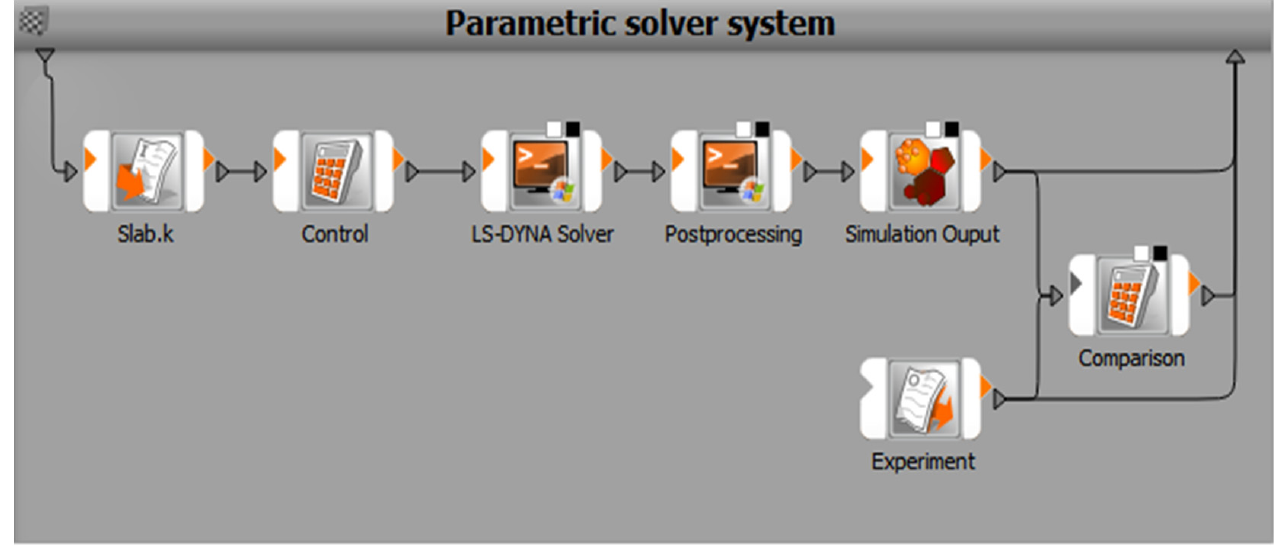
Figure 8. Optimization chain of the material model parameter in the software environment Optislang.